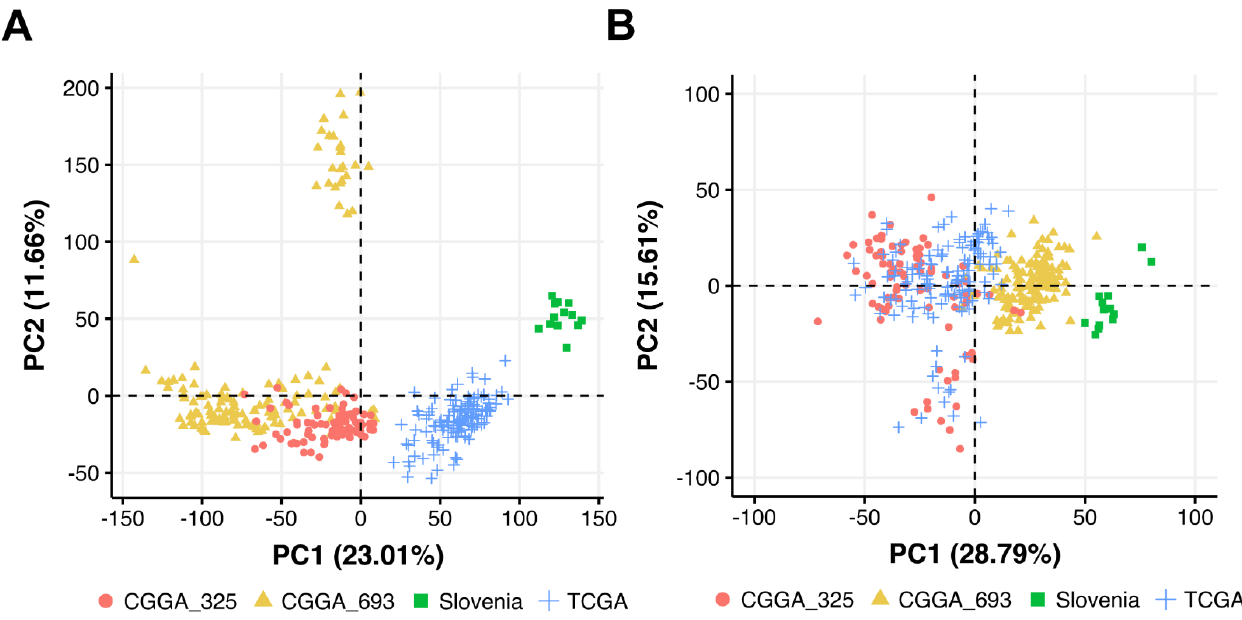
Figure 1. Principal Component Analysis (PCA) of ( A ) gene expression and ( B ) pathway activation levels (PALs) for experimental (Slovenia) clinically annotated glioblastoma tissue samples and publicly available glioblastoma samples from CGGA (batches CGGA_325 and CGGA_693) and TCGA.